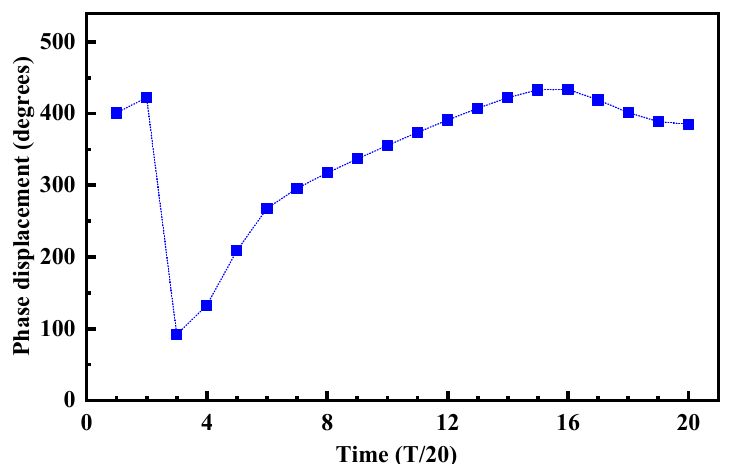
Figure 5. Simulation results of maximum phase difference of output clocks of different bombardment times.